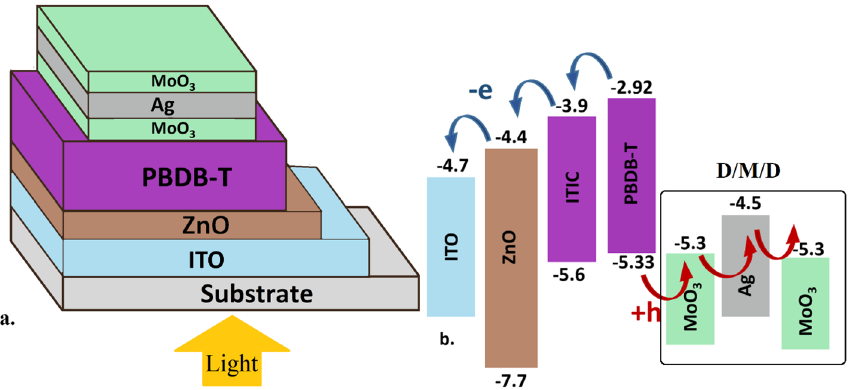
Figure 1. ( a ) Schematic structure, ( b ) The energy level diagram of the materials used in the ST-OSC studied structure 31